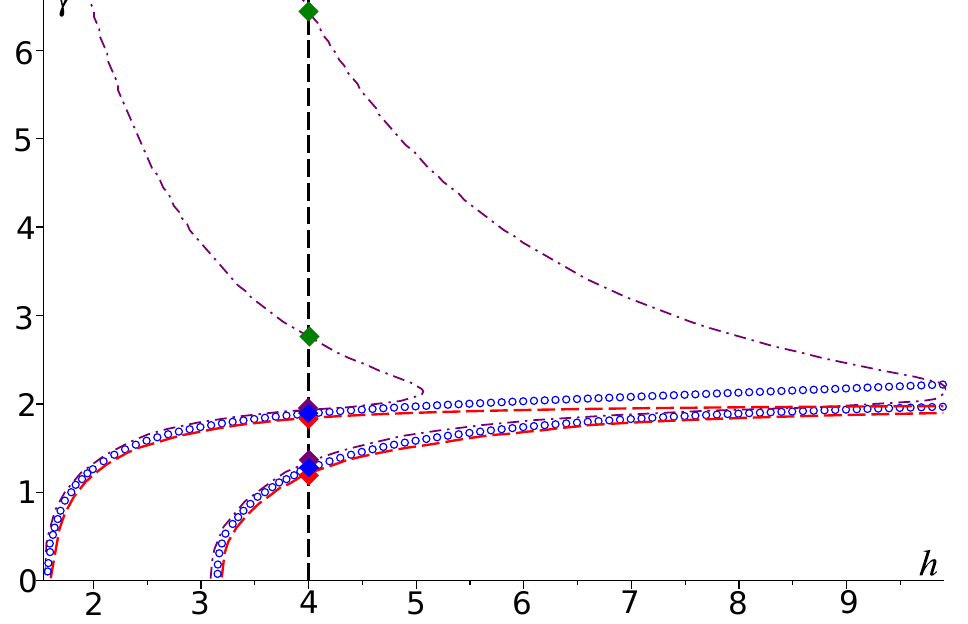
Figure 7. Dispersion curves of problems parameter α = 0.2.